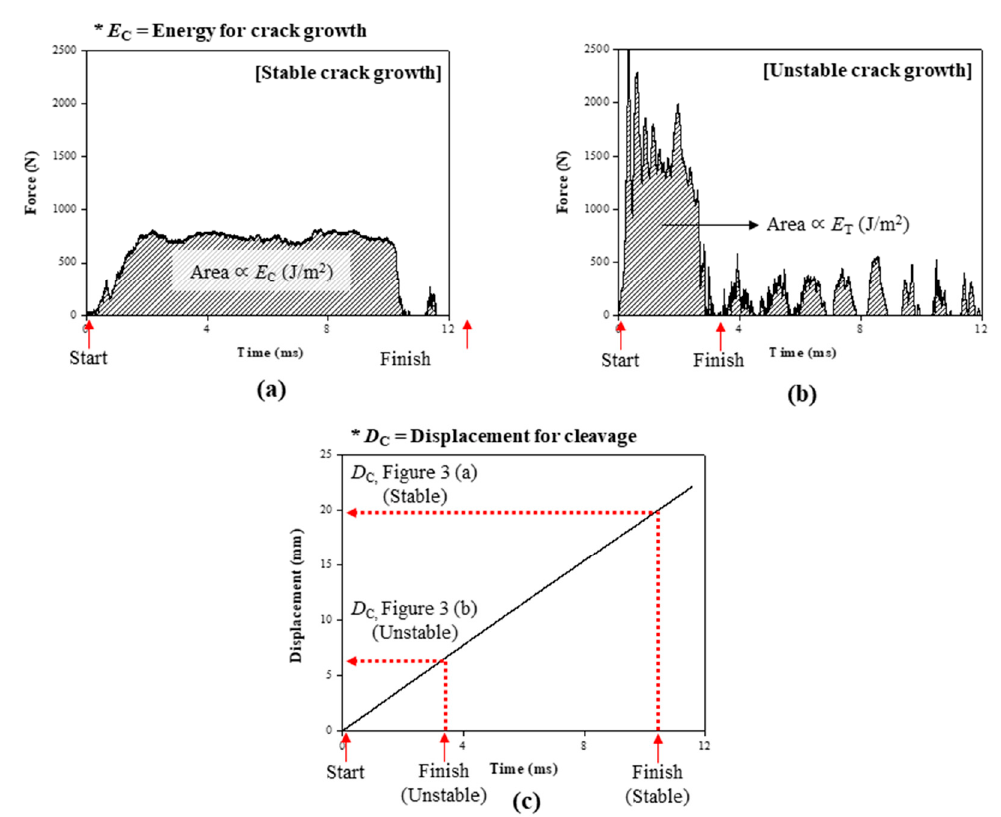
Figure 3. Results of impact wedge–peel test: Time–force curves for ( a ) stable crack growth and ( b ) unstable crack growth. ( c ) Time–displacement curve.